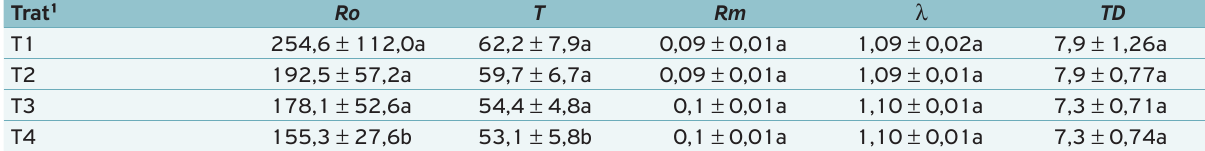
Tabela 2. Parâmetros da tabela de vida de Podisus nigrispinus (Heteroptera: Pentatomidae) alimentado com larvas de Tenebrio molitor (Coleoptera: Tenebrionidae) submetido a diferentes dietas de criação (25 ± 2°C, 70 ± 10% UR e fotoperíodo de 12